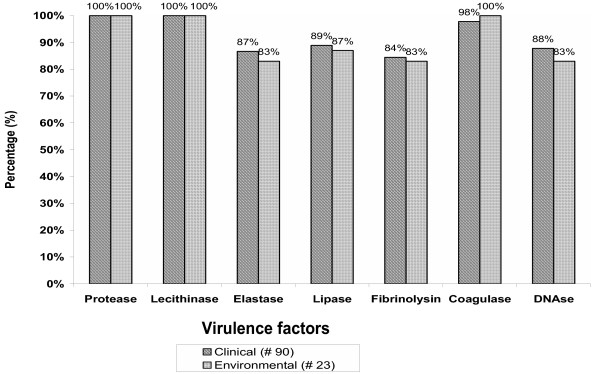
Percentage of clinical and environmental P. aeruginosa isolates producing the virulence factors.